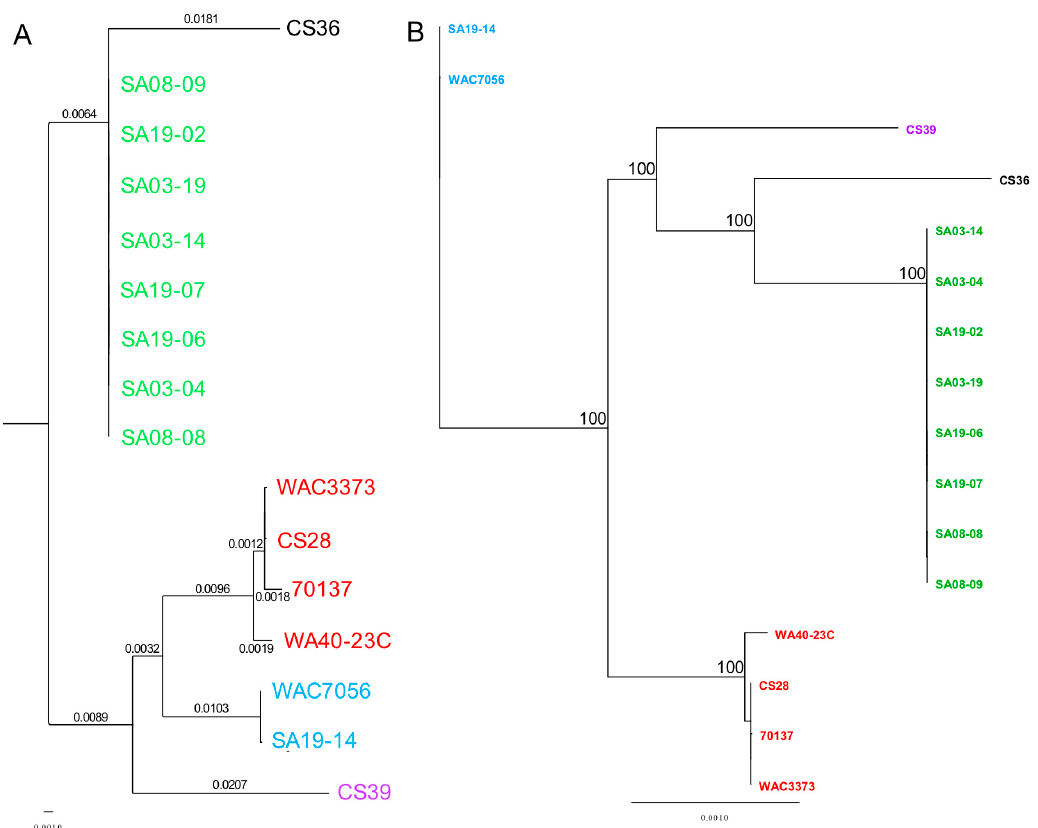
Figure 5. Whole ‐ genome phylogenetic analysis of R. toxicus strains tested in this study. ( A ) Genome sequences were aligned with MAUVE and the tree data were input into Geneious for tree generation. ( B ) Genome sequences were analyzed using REALPHY. The REALPHY alignment data were input into Geneious for tree generation. Neighbor ‐ joining (NJ) trees were calculated using the Jukes ‐ Cantor method to compute evolutionary distances. Confidence intervals were assessed using the bootstrap method with 1000 replications. Strains within the phylogenetic tree are color ‐ coded based on the genetic population. Green: RT ‐ I; blue: RT ‐ II; red: RT ‐ III; black: RT ‐ IV; purple: RT ‐ V.